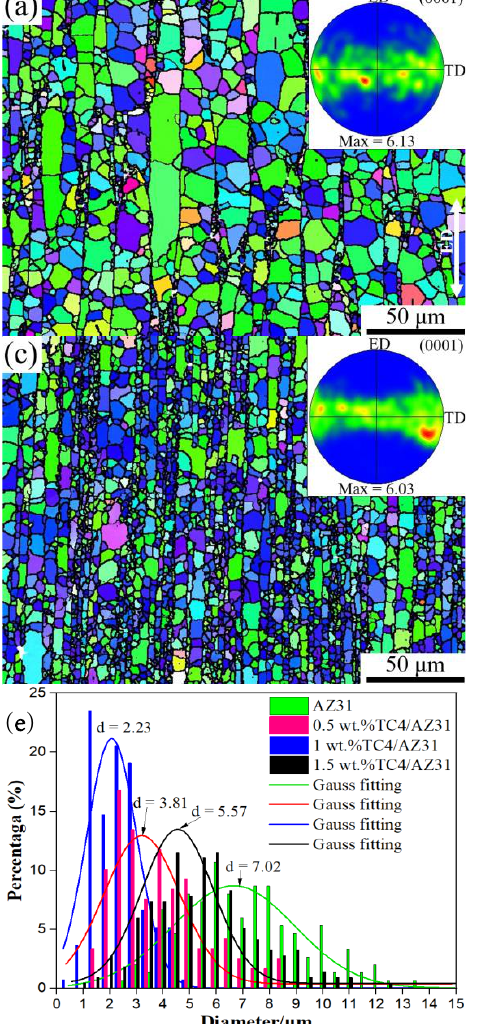
Figure 8. Crystal orientation mapping and macrotexture of ( a ) AZ31, ( b ) 0.5 wt.%TC4/AZ31, ( c ) 1 wt.%TC4/AZ31, and ( d ) 1.5 wt.%TC4/AZ31 as-extruded composites; ( e ) grain size distribution sta-